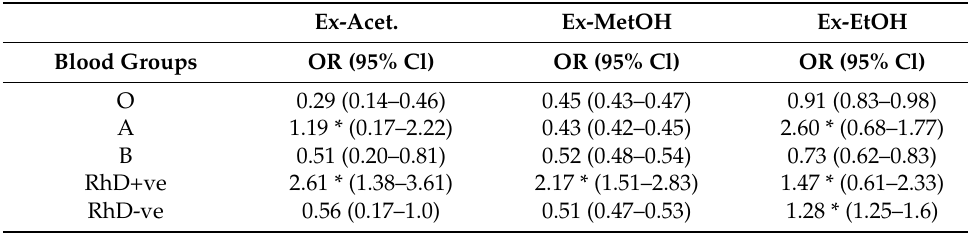
Table 7. Association of ABO blood group and Rhesus factor (Rh) with antihemolytic activity of extract from N. incerta